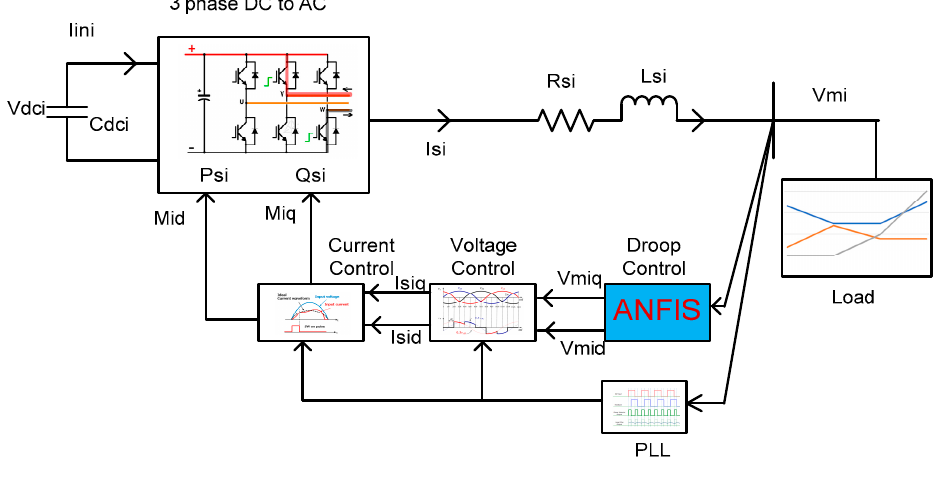
Figure 16. ANFIS droop control model.